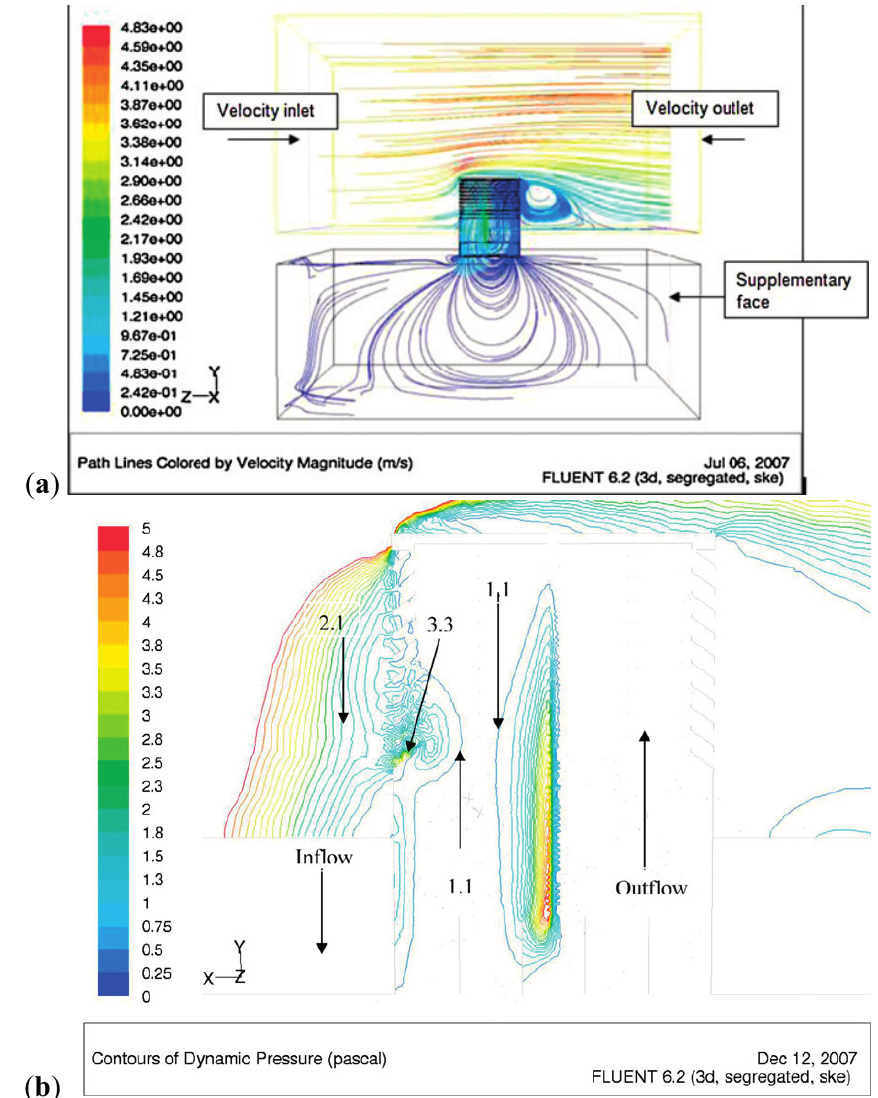
Figure 2. ( a ) Velocity vectors simulating the con-current flow through the wind tower [10]; ( b ) Computational Fluid Dynamics (CFD) calculated pressure contours at louvre angle of 35°